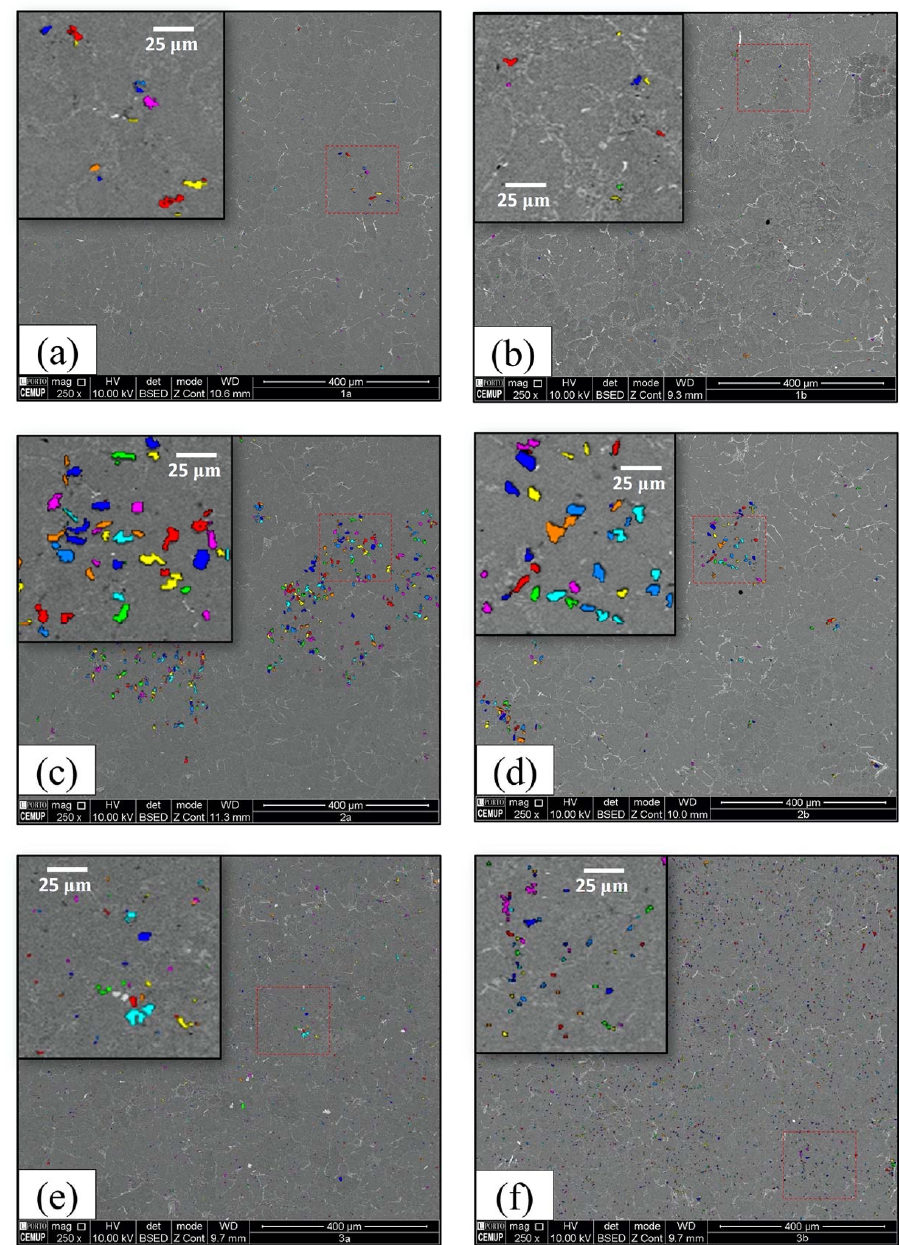
Figure 6. Overview of m ‐ SiCp distribution by SEM according to Figure 4. Condition 1: (( a ) and ( b )); Condition 2: (( c ) and ( d )); Condition 3: (( e ) and ( f )).